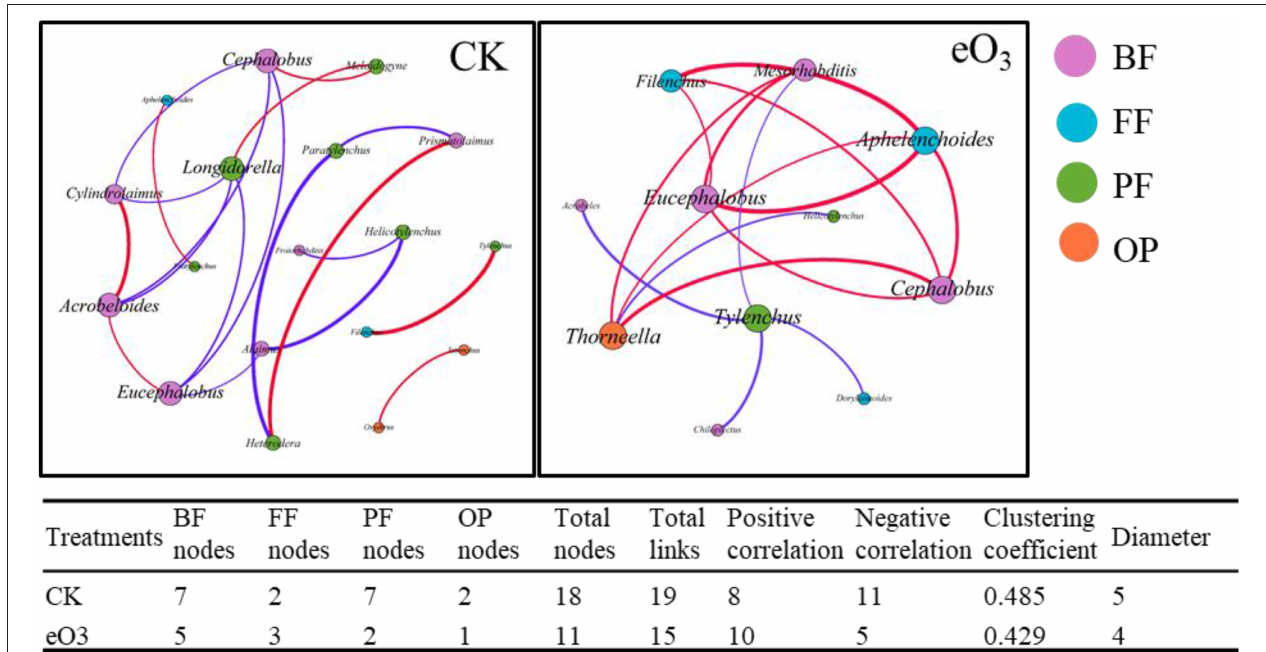
FIGURE 2 | The complexity and interactions of soil nematode community under elevated ozone. The connections represented strong ( R 2 > 0.6) and significant ( P < 0.05) correlations. The size of each node was proportional to the number of connections (degrees). Red lines represented significantly positive and purple lines represent significantly negative correlations. Different colors of nodes represented nematode trophic